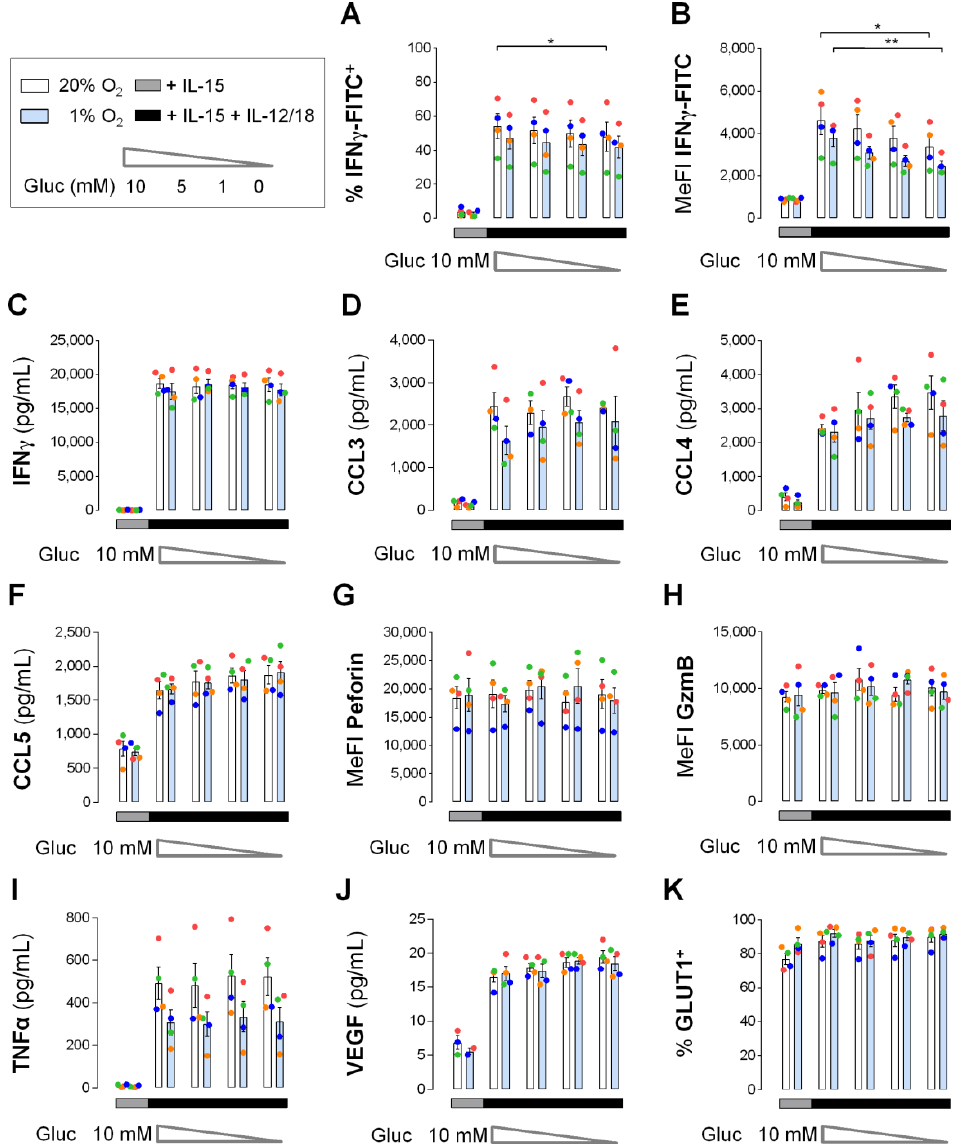
Figure 9. Effector protein levels in human NK cells under concurrent hypoxia and glucose deprivation. NK cells from 4 buffy coats were pre-cultured for 16 h and primed for 6 h with IL-15. For this 22-hour period, one aliquot of cells each was maintained under normoxia (white) and a second aliquot under hypoxia (blue). After priming, both aliquots were washed with glucose-deficient medium and re-seeded into 5 wells each, one well with control medium containing IL-15 and glucose (gray horizontal) and 4 wells with IL-15 plus IL-12/IL-18 and glucose concentrations declining from 10 mM to 0 mM (black horizontal). Controls and secondary stimulations were incubated together for another 4 h under hypoxia. Cells were collected and analyzed for the proportion of ( A ) IFN γ + cells, ( B ) IFN γ MeFI, secreted ( C ) IFN γ , ( D ) CCL3, ( E ) CCL4, ( F ) CCL5, cellular ( G ) perforin and ( H ) granzyme B (GzmB) MeFI, secreted ( I ) TNF α and ( J ) VEGF and ( K ) GLUT1 + cells. Data is shown as mean values ± SEM (bars) and scatter plots in a color scheme to identify data from independent experiments. Within the IL-15 + IL-12/18 group, statistical significance of mean differences between glucose concentrations and between normoxic and hypoxic pre-treatment was determined with the Friedman test with Dunn’s test for post-hoc pairwise comparisons. * p < 0.05, ** p < 0.01. Each condition in the IL-15 + IL-12 / 18 group was compared individually to the IL-15 control with the same pre-treatment oxygen level with the Wilcoxon signed-rank test but none reached the level of statistical